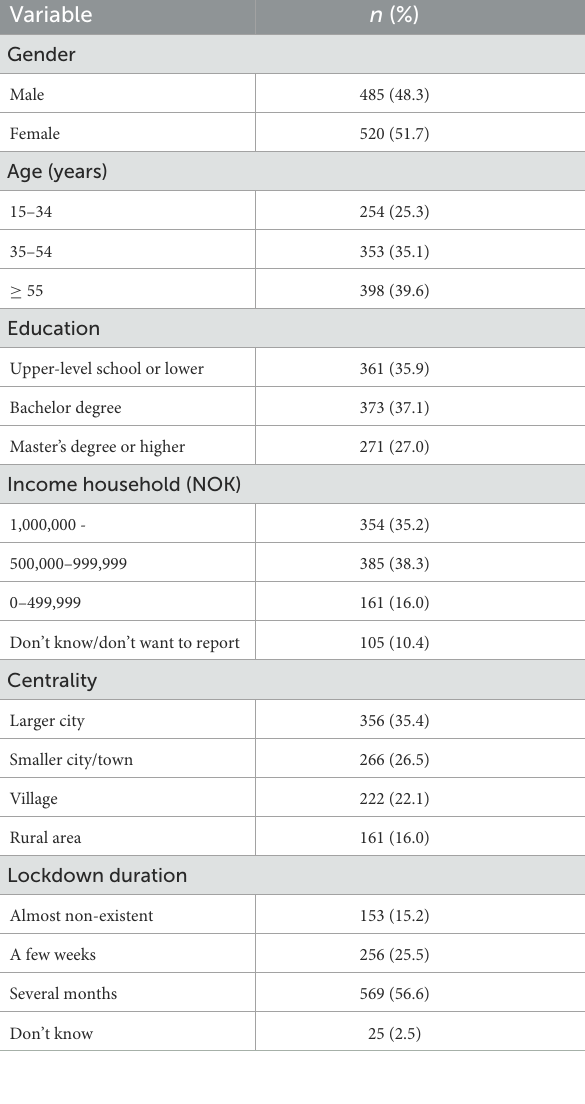
TABLE 1 Sociodemographic characteristics and duration of lockdown restrictions for all participants ( n =